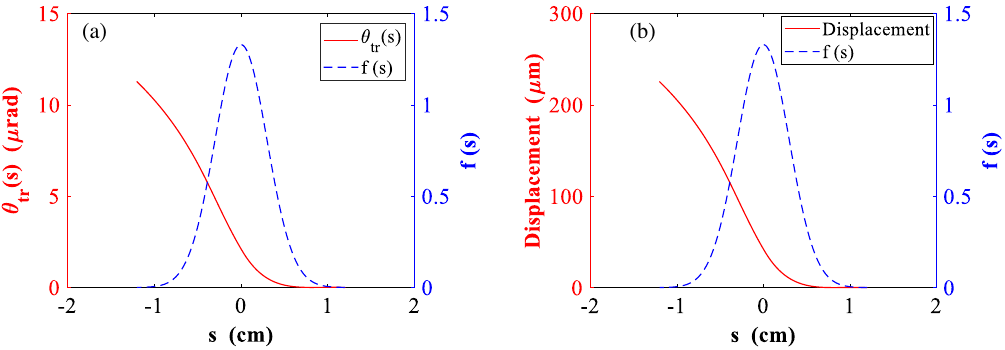
FIG. 9. (a) Plot of the s -dependent kick angle in microradians (red) within the 10-ps-long micropulse (blue curve) for a 500-pC charge, a 5-mm offset, and 33 MeV. (b) Plot of the s -dependent transverse displacement in microns (red) with M 12 ¼ 20